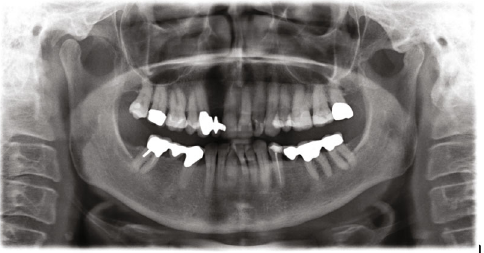
Figure 2: The orthopantomogram (OPT) shows a bone defect in the region of the right lateral incisor.